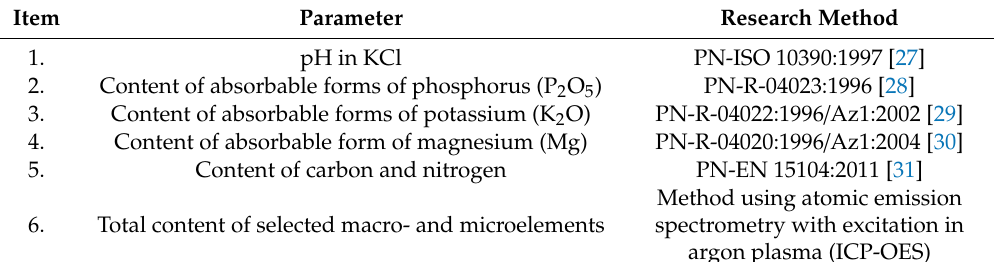
Table 3. The parameters analysed with the research methods